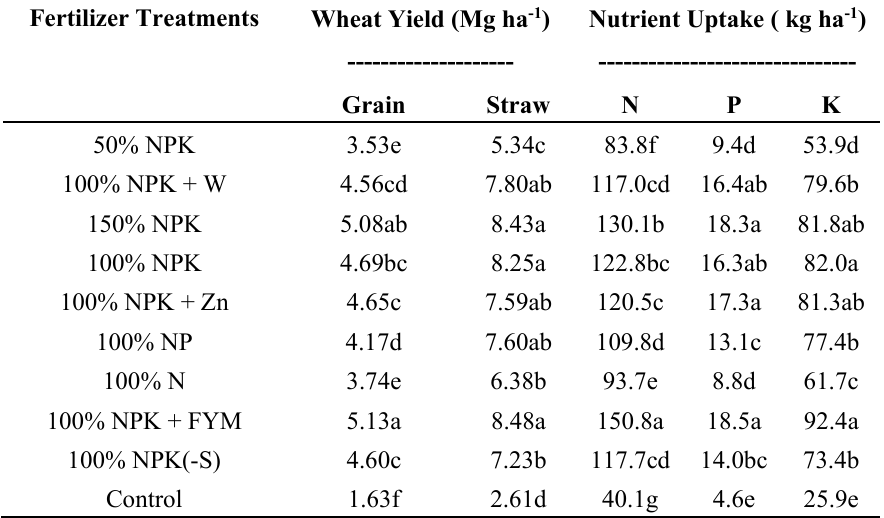
Table 5. Wheat yield and nutrient uptake as affected by long-term use of organic and inorganic fertilizers in